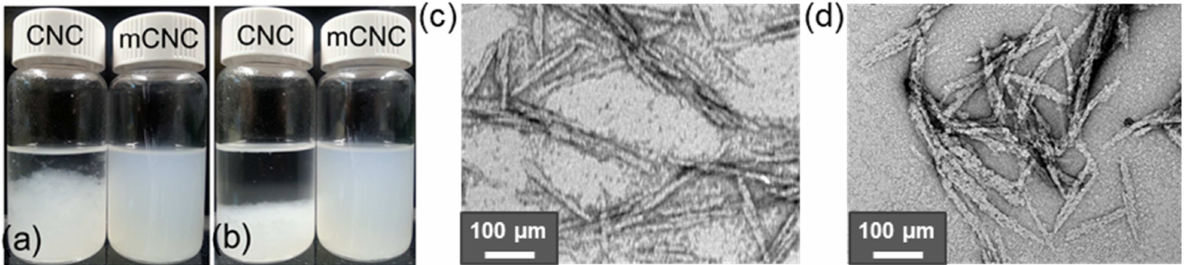
Figure 10. Images of neat CNC and modified CNC (mCNC) in chloroform after 15 min sonication ( a ) and after 15 min sonication and standing ( b ); TEM images of neat ( c ) and modified ( d ) CNC (reproduced from [186] with permission of Royal Society of